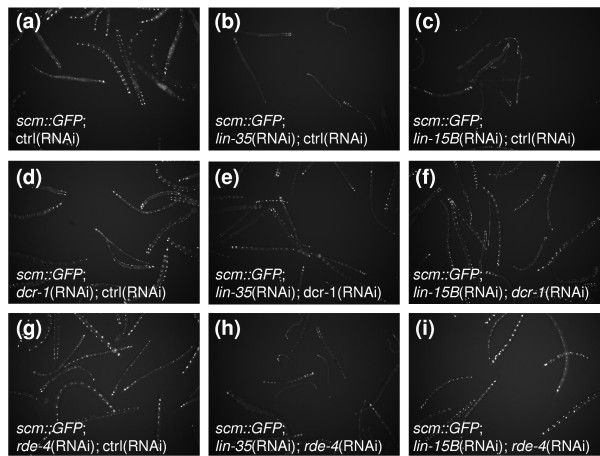
lin-35 and lin-15B enhance somatic transgene silencing by an RNAi dependent mechanism. Worm strain JR667 expresses GFP specifically in the hypodermal seam cells from an integrated tandemly repeated array of the construct wIs51, which contains the scm::GFP reporter (a). Inactivation of either lin-35 (b) or lin-15B (c) results in enhanced silencing of the GFP transgene via a mechanism that is dependent upon the RNAi machinery, including dcr-1 (e-f) and rde-4 (h-i). Inactivation of dcr-1 (d) or rde-4 (g) alone results in a slight increase in GFP expression, indicating a background level of transgene silencing in wild-type worms. Worms were fed on 1:1 mixes of the indicated RNAi feeding strains and RNAi feeding experiments were performed as described in Materials and methods. Control (ctrl) RNAi experiments used the same non-targeting RNAi clone as used in Figure 1. See Table 5 for quantification of this data.